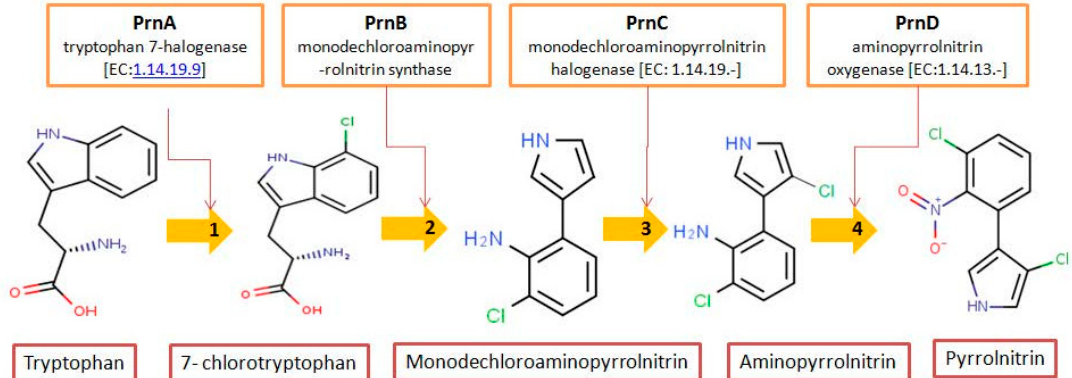
Figure 1. Biosynthetic steps in the synthesis of pyrrolnitrin. 7-chlorotryptophan is formed from